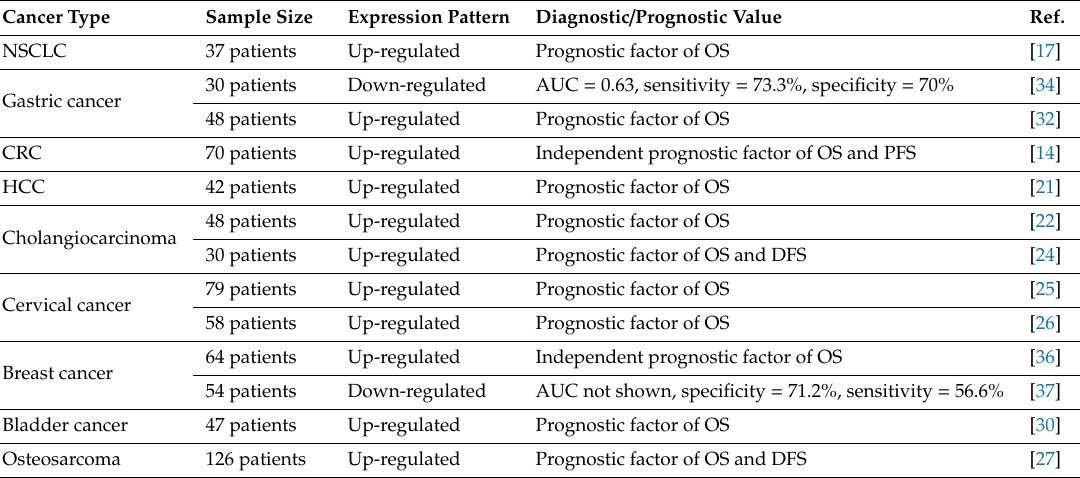
Table 2. Diagnostic or prognostic value of NNT-AS1